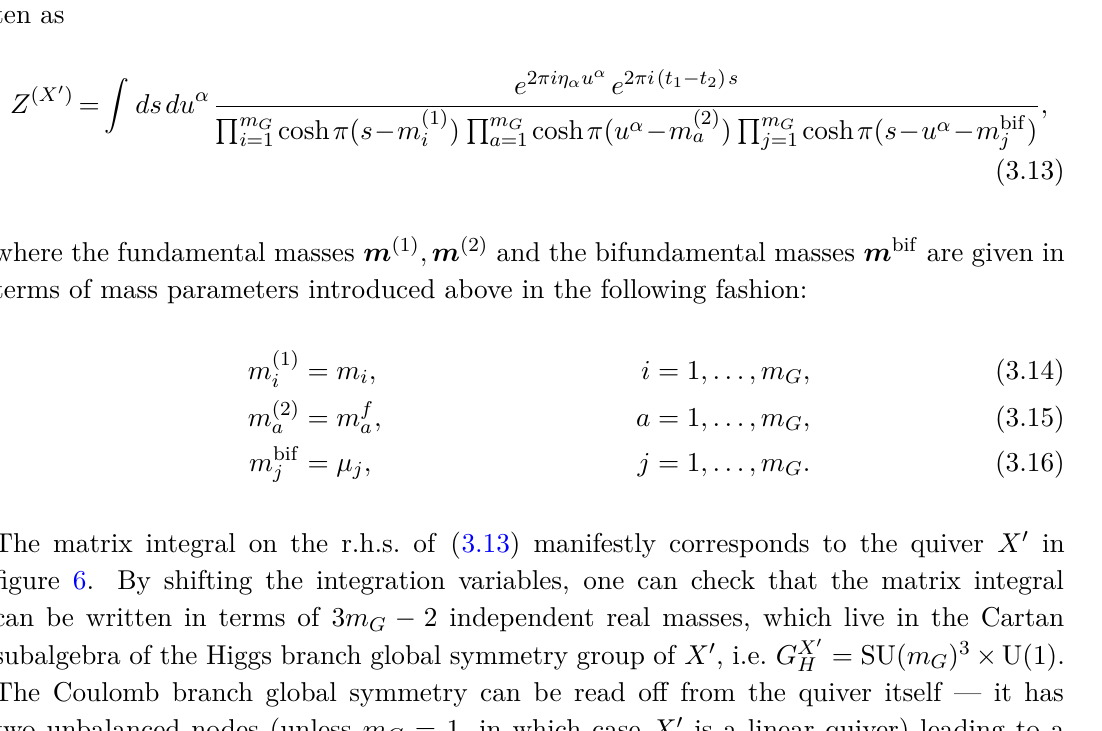
figure 6. By shifting the integration variables, one can check that the matrix integral can be written in terms of 3 m − 2 independent real masses, which live in the Cartan G subalgebra of the Higgs branch global symmetry group of X 0 , i.e. G X 0 The Coulomb branch global symmetry can be read off from the quiver itself — it has two unbalanced nodes (unless m = 1 , in which case X 0 is a linear quiver) leading to a G = U(1) 2 G X 0 C